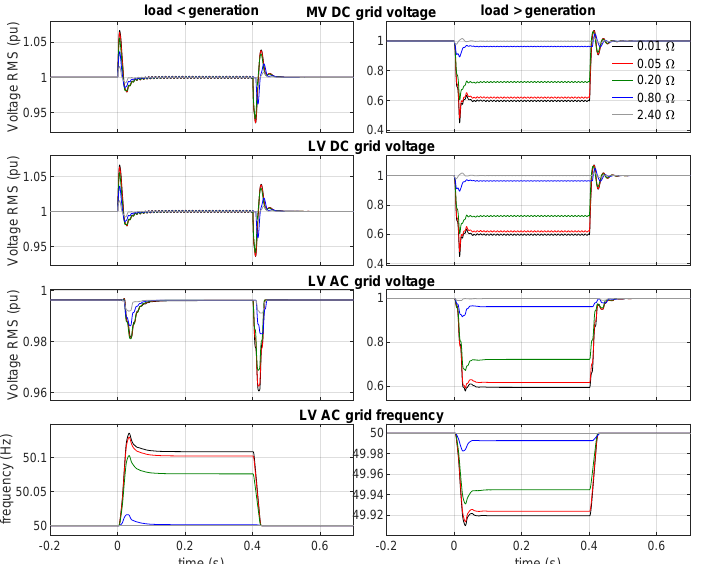
Figure 21. Voltage and frequency levels in the hybrid AC/DC network following unbalanced phase–phase faults in the HV AC grid for the considered fault